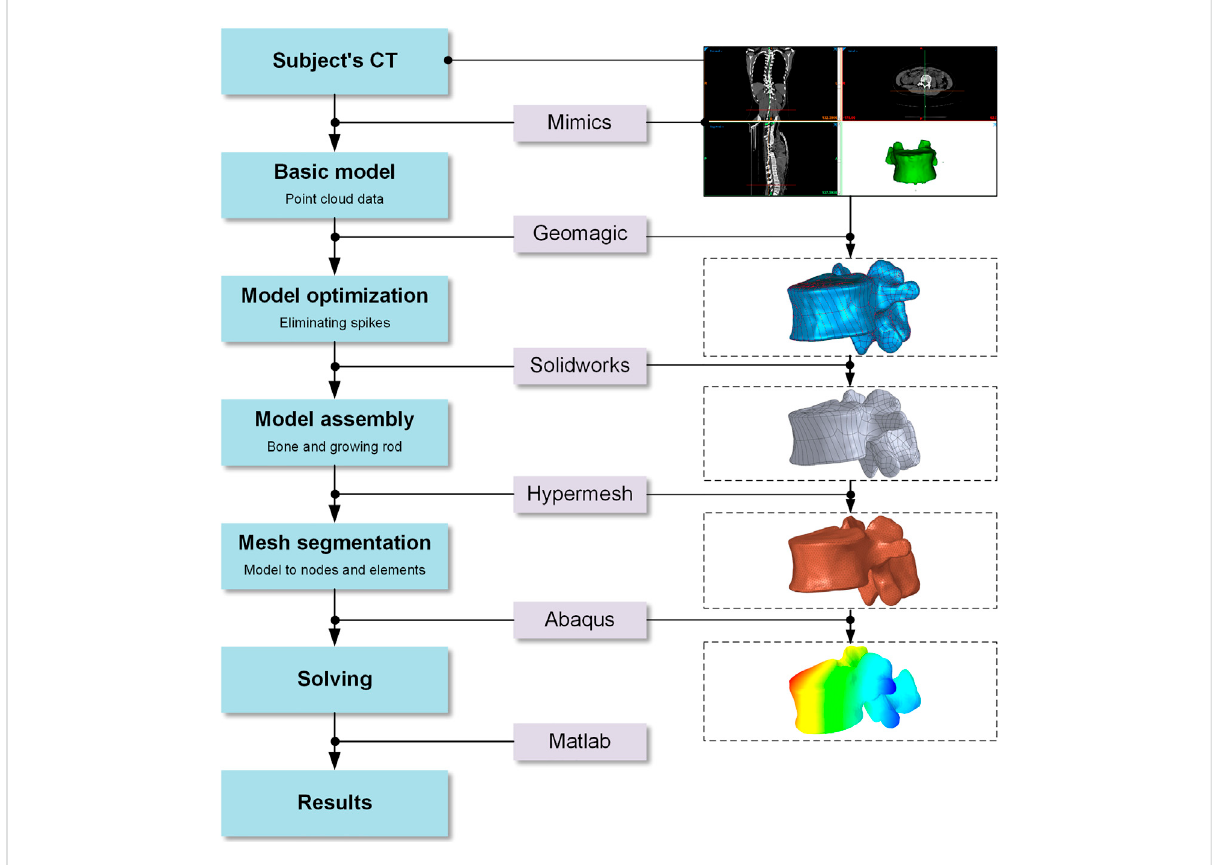
FIGURE 2 Modeling process in this